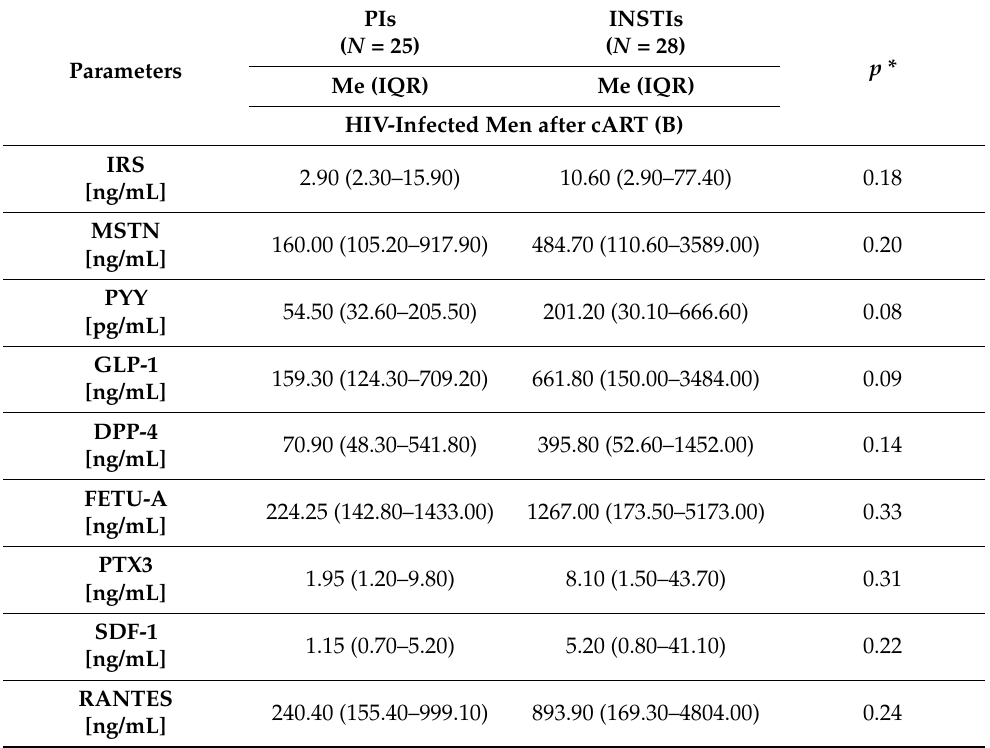
Table 6. Results of selected parameters in HIV-infected men after cART in the subgroup with protease inhibitors (PIs) treatment and the subgroup with integrase transfer inhibitors (INSTIs) treatment with statistical